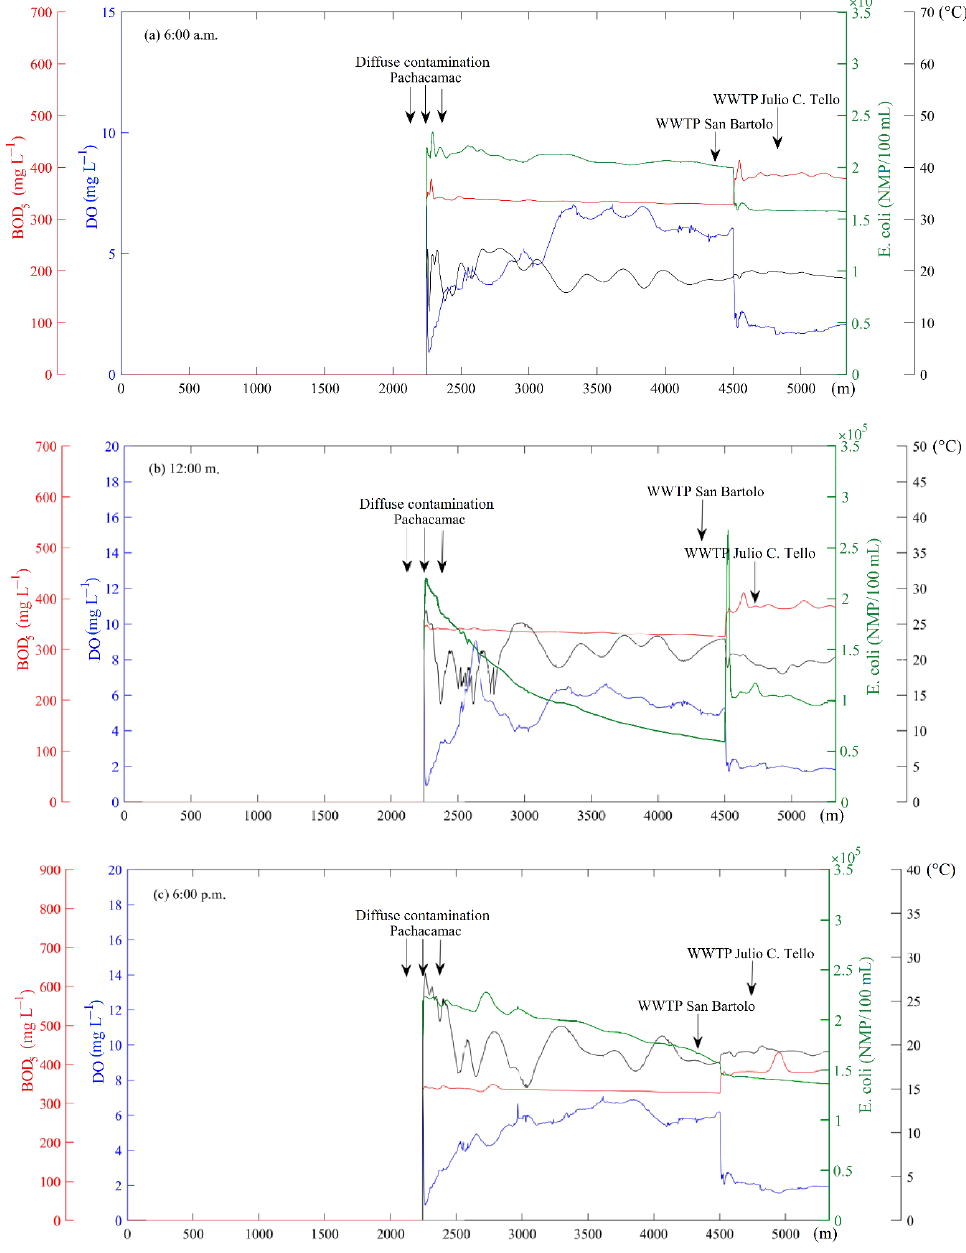
Figure 6. Longitudinal profile of the current situation of the river according to DO, BOD 5 , E. coli, and T (from L5 to L1): 6 a.m. ( a ), 12 m. ( b ) and 6 p.m. ( c ). Red line is BOD 5 , blue line is DO , green line is E. coli , and black line is T .